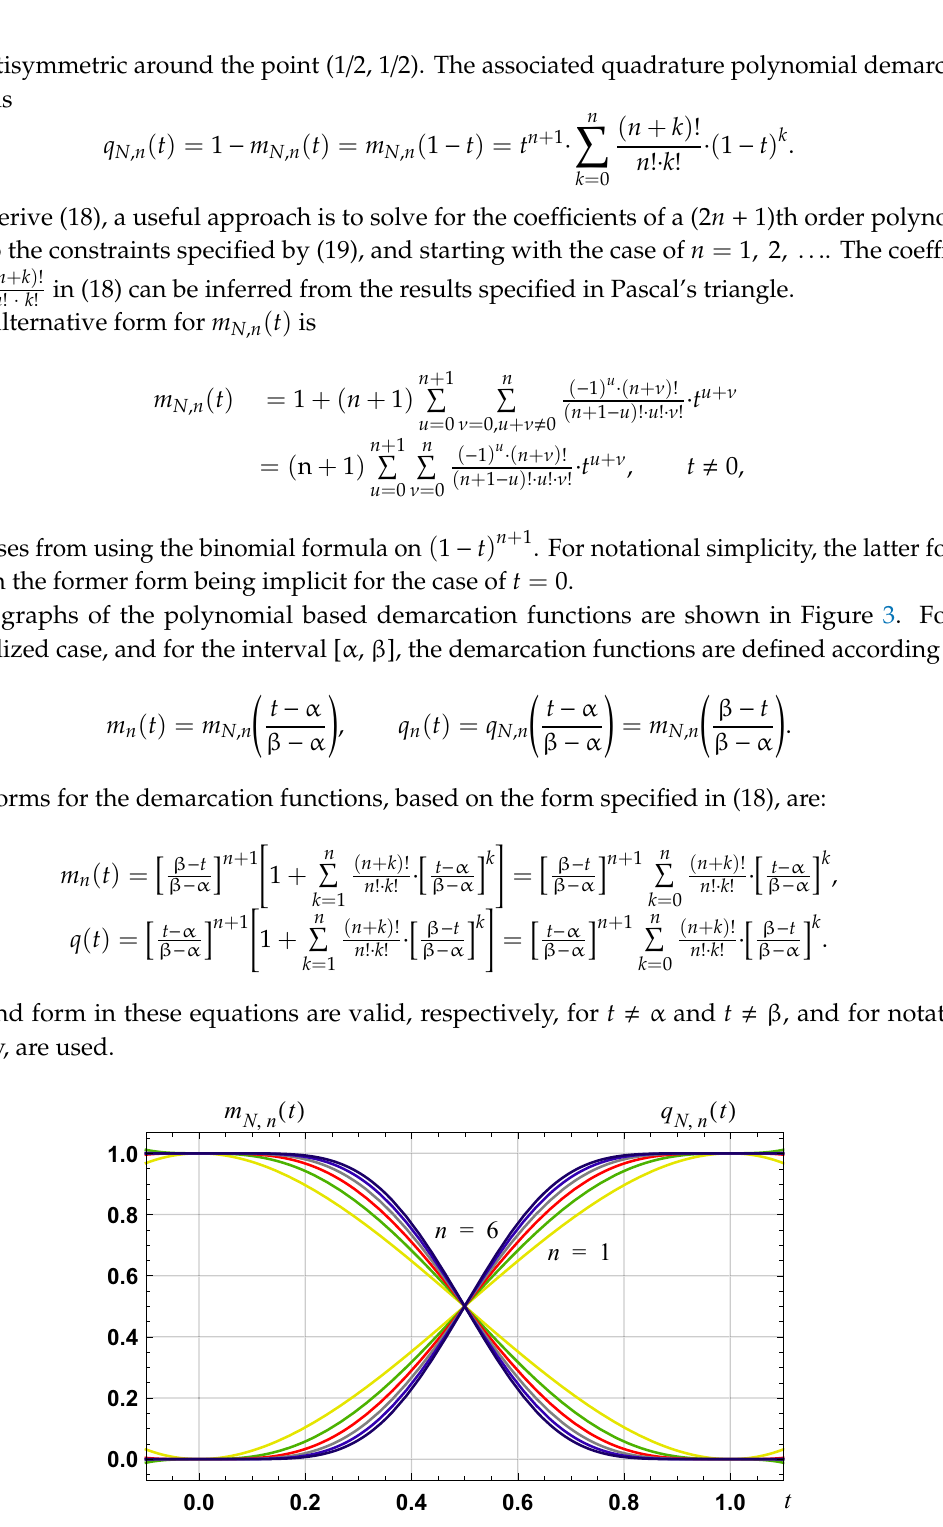
Figure 3. Graph of the normalized polynomial demarcation functions, of orders one to six, for the interval [0,